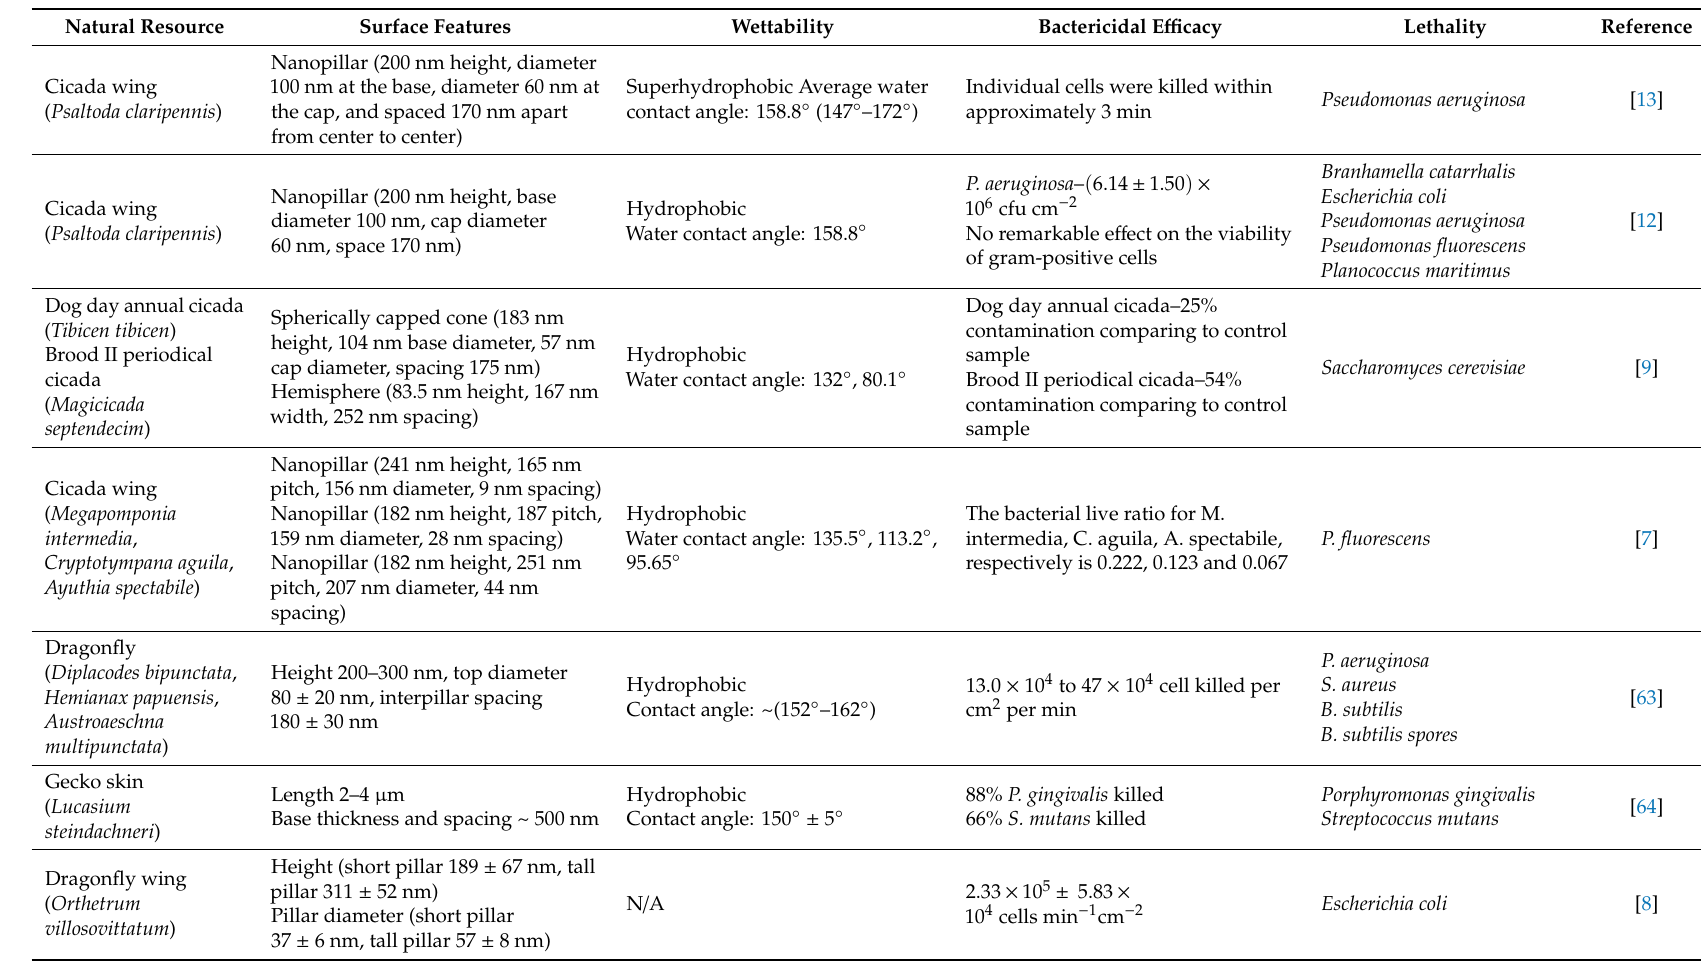
Table 2. Naturally occurring bactericidal